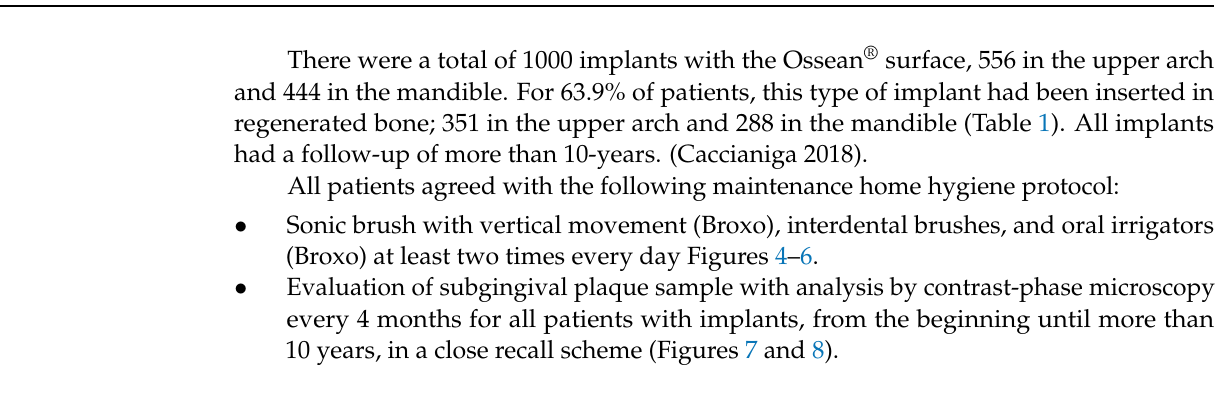
Table 1. Number of implants with Ti-Unite surface and Ossean surface, both in pristine and regenerated bone. IMPLANTS Implants with Ti-Unite surface